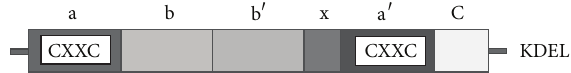
Figure 1: Domains of PDIA1. TRX-like domains representing catalytic active domains a a 󸀠 . The b domain and b 󸀠 are catalytically inactive. The linker region is responsible for binding to the substrate. The C terminal is followed by an ER retrieval signal